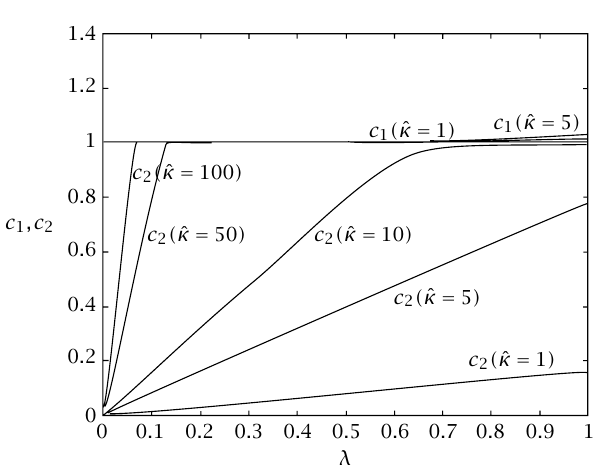
Figure 3.1 . The velocities c 1 and c 2 as functions of λ ( 0 ≤ λ ≤ 1 ) for fixed values of ˆ κ .